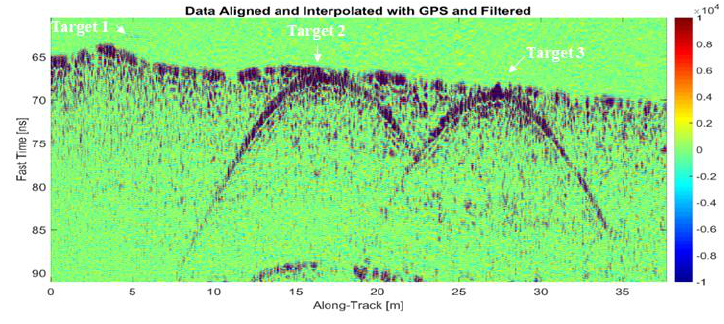
Figure 9. Processed radargram Test 1-Track 1: ( a ) aligned ad interpolated radargram by exploiting GPS information and after filtering operations; ( b ) aligned and interpolated radargram by exploiting CDGPS information and after filtering